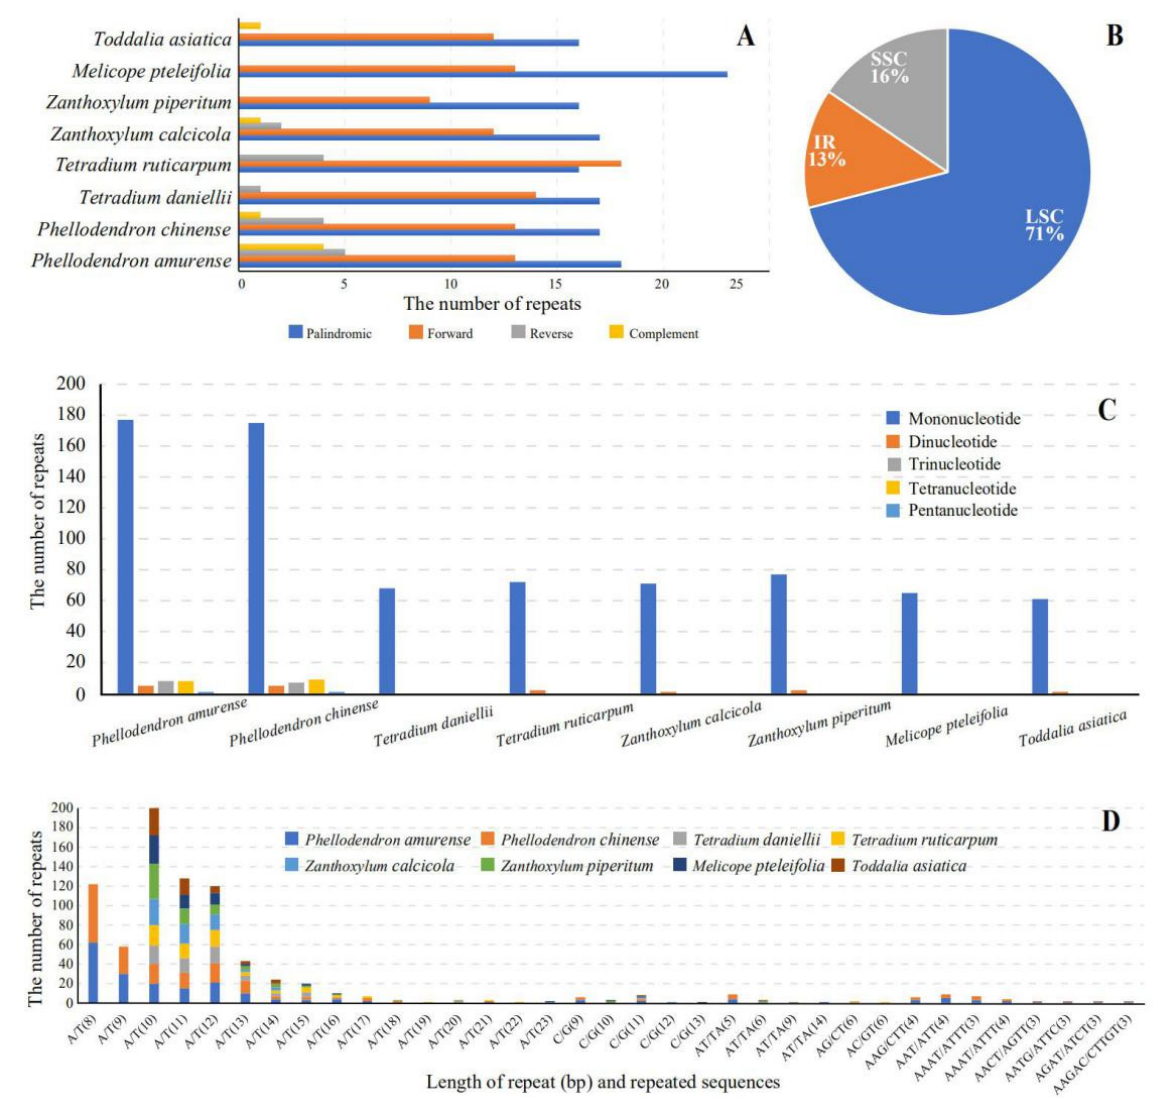
Figure 3. Simple sequence repeats of the plastomes of the eight species. ( A ) Number of four repeat types; ( B ) Proportion of SSRs in different genomic regions; ( C ) Number of different SSRs types detected in plastome. ( D ) Number of SSRs in different repeat class types.